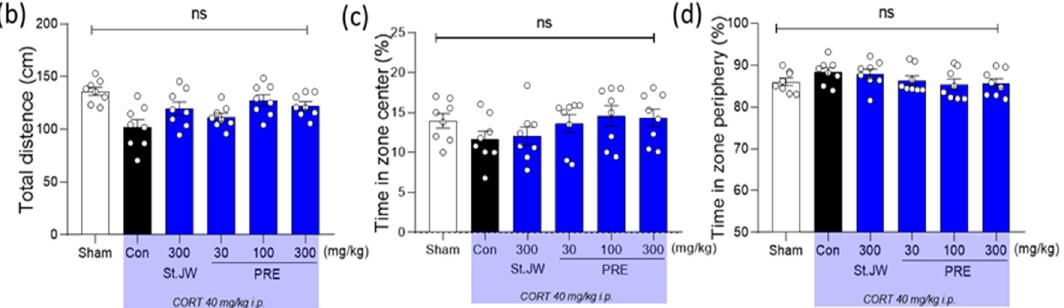
Figure 1. Effect of PRE on open filed test in CORT-induced depressive mice. A representative trace of locomotor activity across 5 min ( a ) in the OFT. There was no significant difference in total distance moved ( b ), time spent in the center ( c ), or periphery ( d ) of the OFT, between the treated groups. Results are presented as mean ± SEM ( n = 8, per group). Differences among experimental groups were determined by analysis of variance (ANOVA) test. Con, control; CORT, corticosterone; St. JW, St. John’s wort extract; PRE, P. resupinata extract.